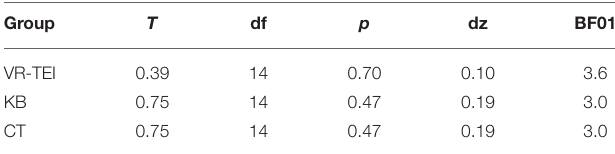
TABLE 1 | Calculated t values (t), degrees of freedom (df), and p- values for the paired samples t -tests, Cohen’s d z , and Bayes factors (BF 01 ) for the analyses in which pre-intervention and post-intervention SBST scores were compared for each group